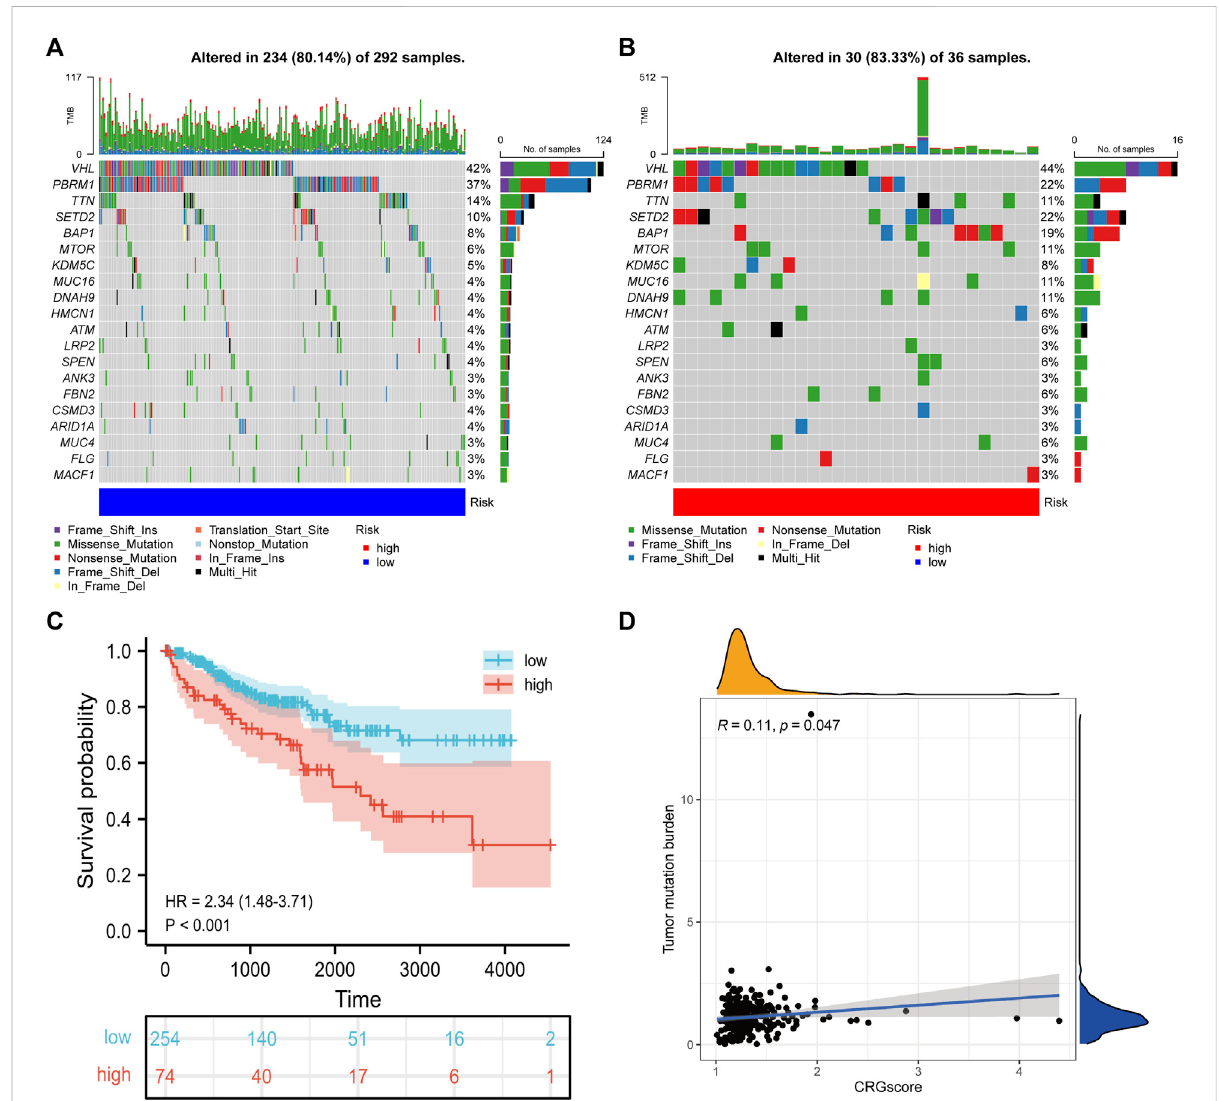
FIGURE 12 Somatic variants of the CRGscore-de fi ned groups. (A,B) Mutation spectrum of the top 20 mutated genes. (C) Survival analysis of the TMB- de fi ned groups. (D) The relevance of TMB with CRGscore was revealed through the correlation